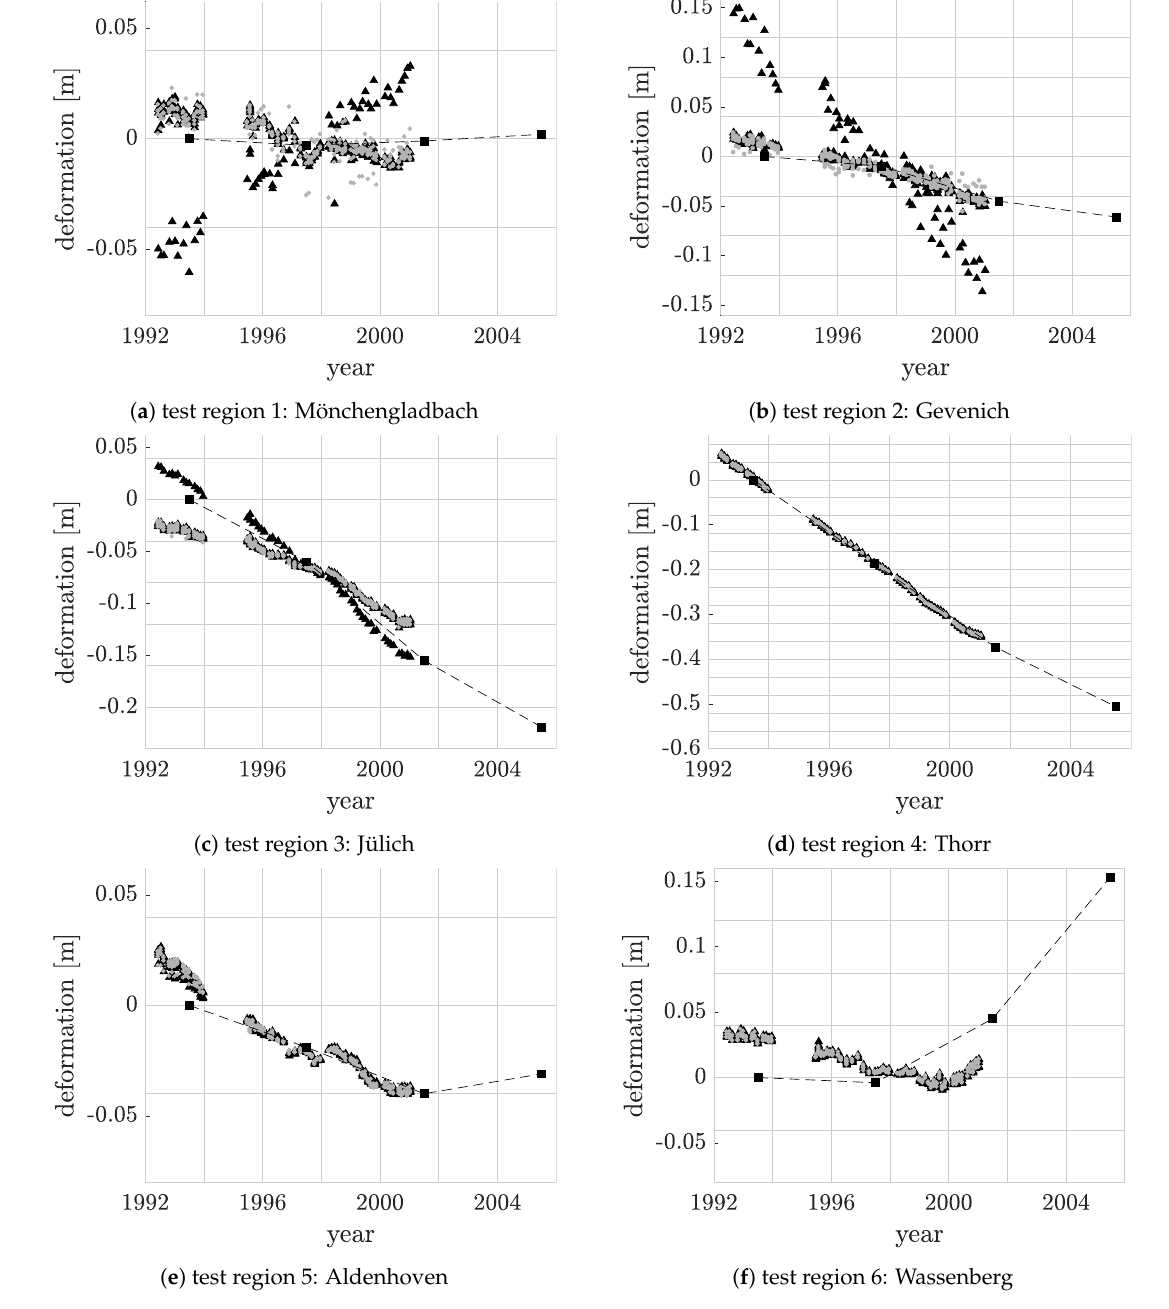
Figure 11. Deformation time series of five points lying in each of the six highlighted test region shown in Figure 10. The black triangles are the results using the conventional approach and the light gray points are the results using the alternative way. For comparison the black squares indicate the data from the closest leveling